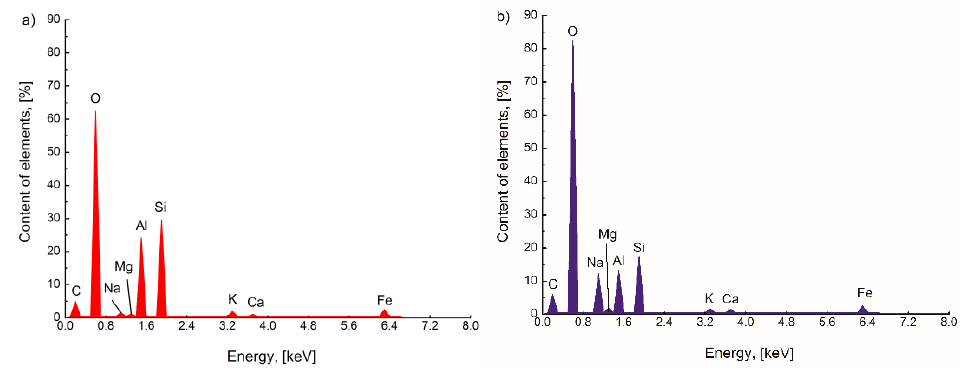
Figure 2. Energy dispersive spectroscopy (EDS) spectra of coal fly ash; ( a ) raw FA and ( b ) H 2 O 2 -treated FA.